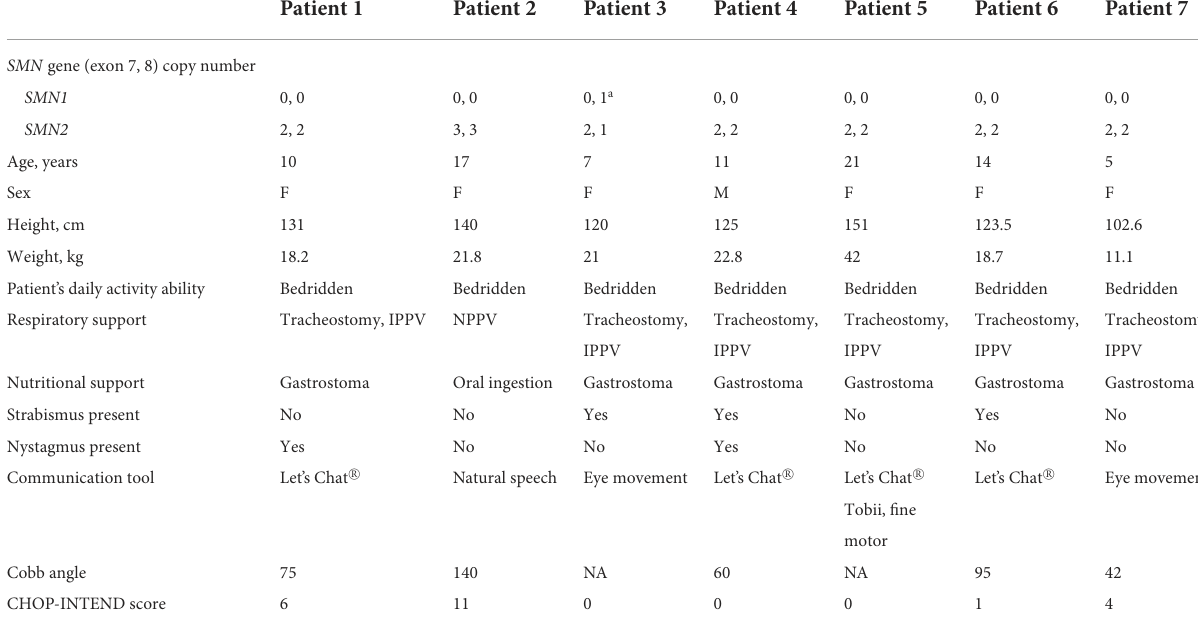
TABLE 1 Patient characteristics.